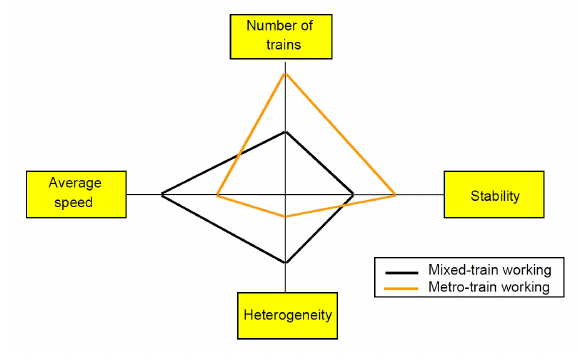
Figure 2. Capacity balance